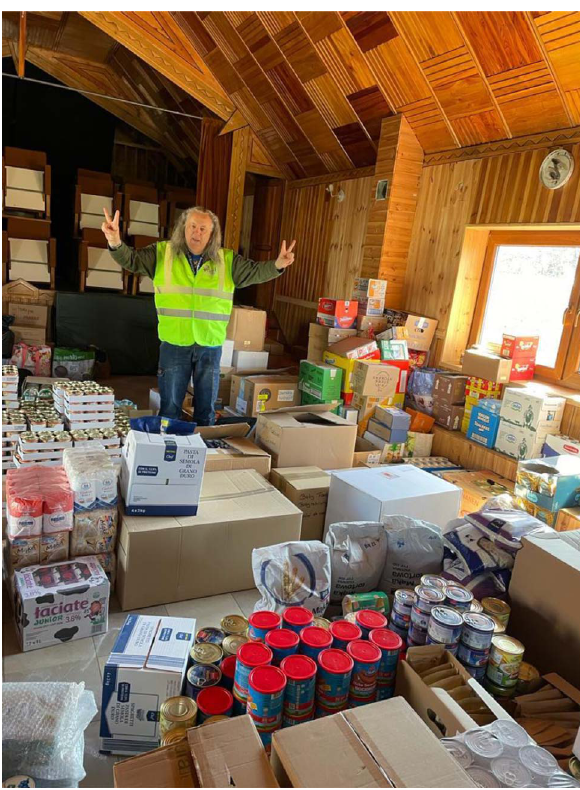
Figure 1. Ralf Bartzsch, German Veterans, Recondo Vets MMC, Military Motorcycle Club (MMC), Germany at the Interim storage of Ukraine aid goods to the International Legion of Territorial Defense of Ukraine (Ukrainian Foreign Legion) (I yn ep y a w io y a kmybq k e u io y n ep bn opia kmy o ї o , opo yb Er pa ї yb ). Ralf Bartzsch gave permission that this picture is published.